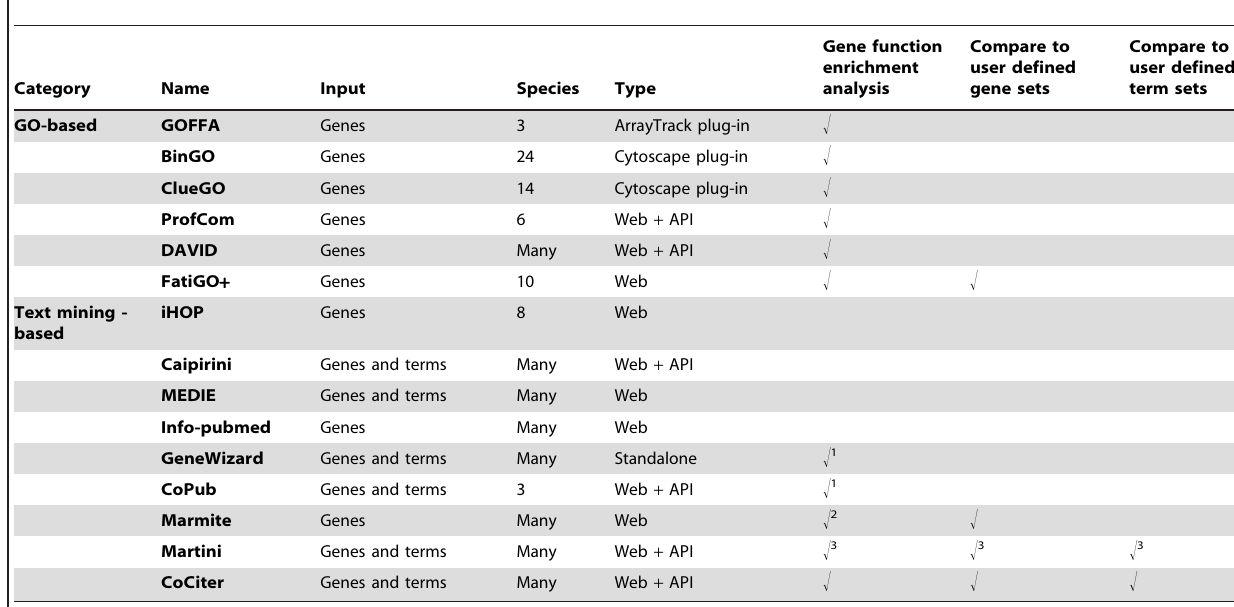
Table 1. Unique features of CoCiter compared with those of existing gene function analysis tools.